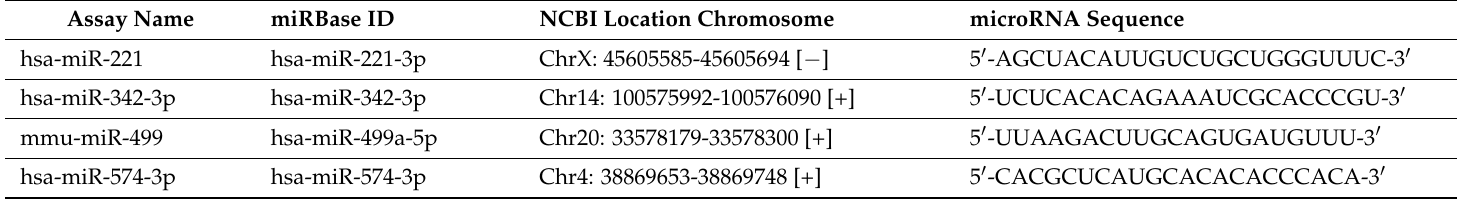
Table 5. Characteristics of microRNAs involved in the